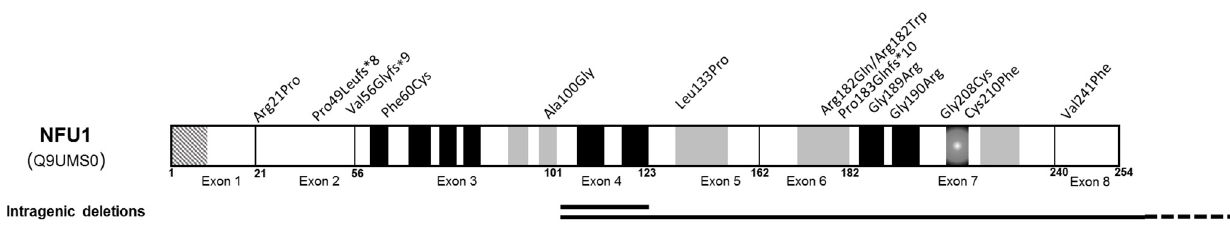
Figure 2. Schematic of NFU1 protein (NP_001002755) with reported variants. Missense and truncating variants are indicated above and intragenic deletions below the protein structure. Schematic secondary structure shows α -helix (grey), β -strand (black), and turn (grey and black crosshatchings). The mitochondrial targeted sequence corresponds to the 10 first